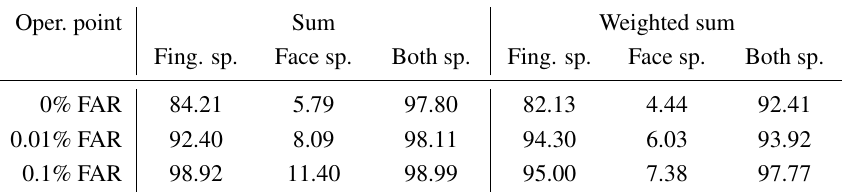
Table 3. FAR (%) of the face–fingerprint system in parallel fusion mode, with the sum and weighted sum using worst-case spoof attack assumption, when either the face, the fingerprint or both the face and fingerprint are spoofed, at three operating